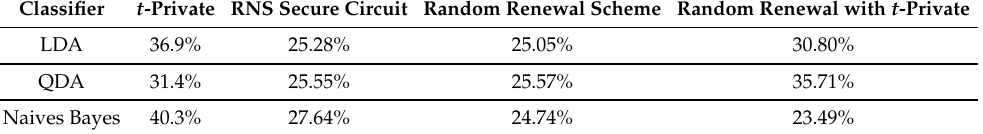
Table 5. Success rate on t -private, base RNS, random renewal, random renewal with t -private with a single shared random